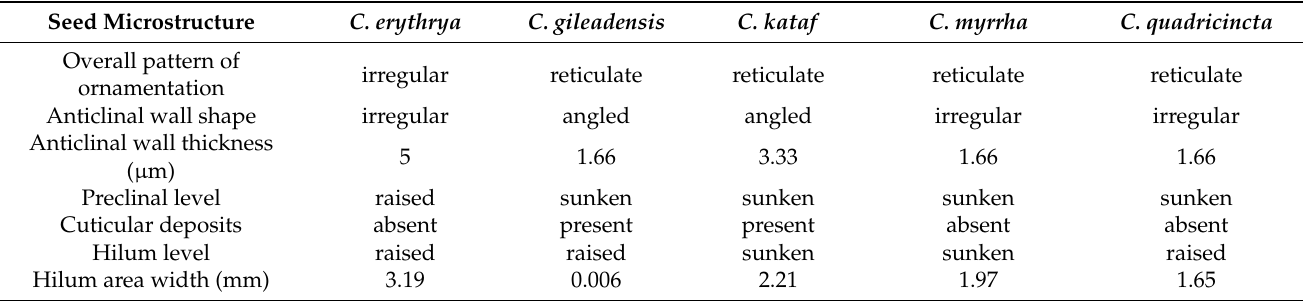
Table 5. Seed micro-morphological variations of Commiphora species using